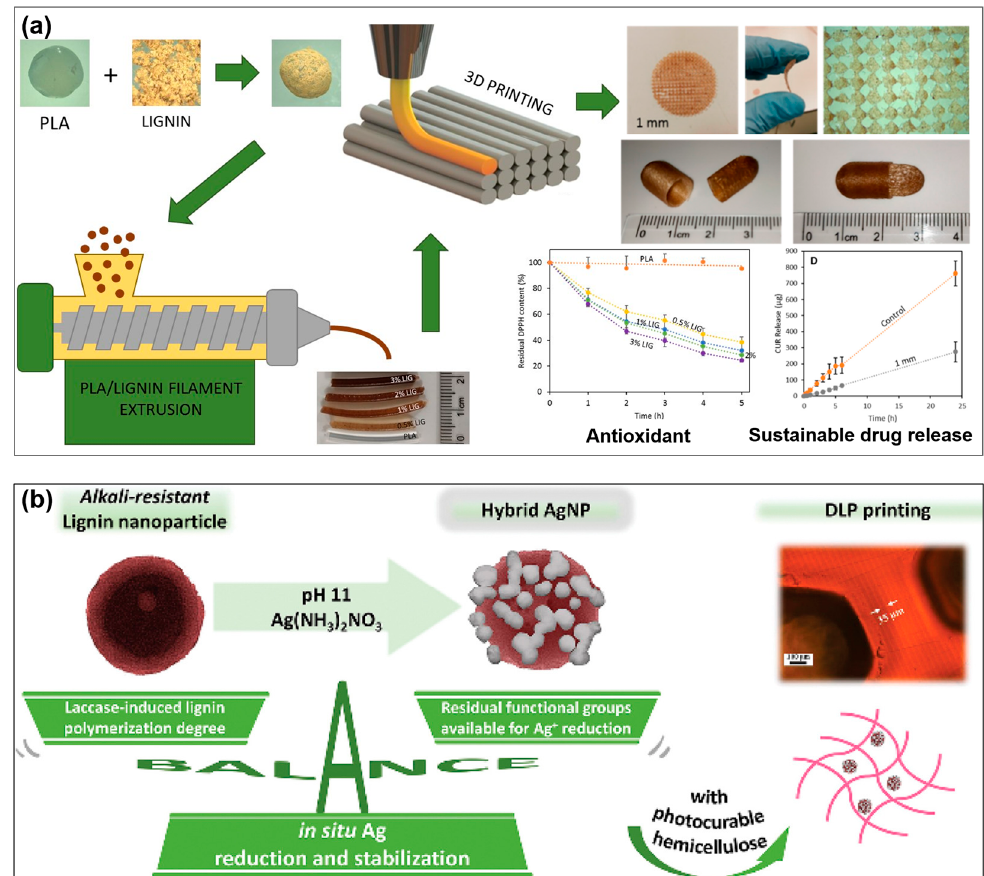
Figure 5. ( a ) Schematic illustration of FDM printing antioxidant PLA composites containing lignin and their applications in sustained drug release (adapted from ref [168] with permission). ( b ) Schematic illustration of DLP printing an antimicrobial hydrogel via integrating lignin nanoparticles (LNPs) decorated by AgNPs (Ag@LNP) in a methacrylated O-acetyl-galactoglucomannan (GGMMA) network (adapted from ref [167] with permission).